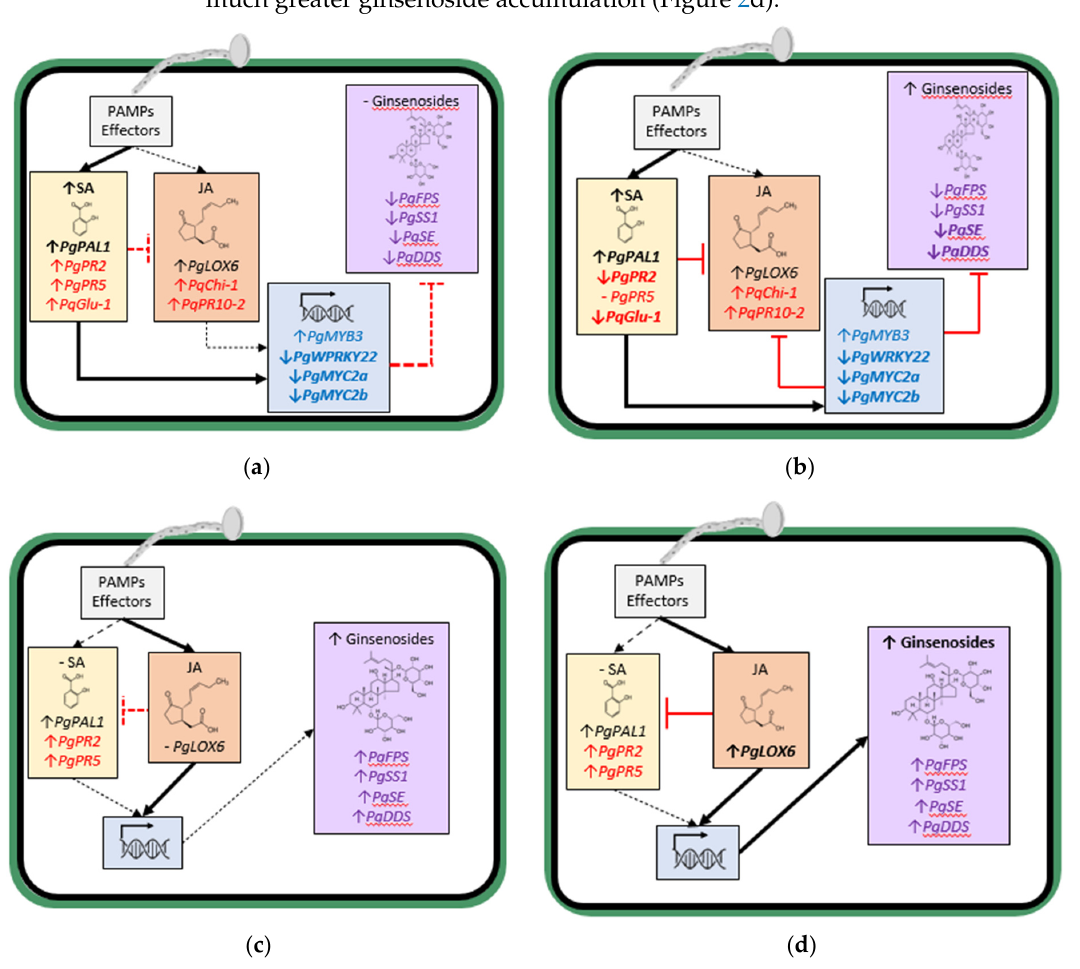
Figure 2. Aspects of SA and JA-associated host responses in ginseng roots with ( a ) the more aggressive I. mors-panacis at the early stage (0.5–8 dpi); ( b ) and late stage of infection (9–30 dpi); ( c ), and the less aggressive Ilyonectria spp. at the early stage (0.5–8 dpi); ( d ) and late stage of infection (9–30 dpi). Black lines between boxes indicate induction and red lines between boxes indicate suppression with dashed lines indicating a weak response and solid lines indicating a strong response. SA and JA synthesis gene designations are in black, PR protein gene designations are in red, TF gene designations are in blue, and ginsenoside synthesis gene designations are in purple. Arrows adjacent to gene designations indicate up or down gene regulation with bold indicating a stronger response. Illustration created with BioRender [18]. 4. Pathogenesis-Related Proteins PAMPs or effectors of plant pathogens typically trigger the production of host pathogenesis-related proteins (PR proteins) [49], which includes antioomycete and antifungal compounds, such as thaumatin-like proteins, chitinase and glucanase fungal cell wall degradation enzymes, proteinase inhibitors, and ribonucleases [50]. Among the DEGs identified in P. ginseng roots infected by C. destructans [29] , there were 29 DEGs for defence response, which included genes for the PR proteins, c55244_g1 described as part of the Bev v 1 family, and c58299_g4 without a description. Expression of c55244_g1 decreased from 0 to 0.5 dpi, increased at 4 dpi and decreased again at 7 dpi. Expression of c58299_g4 increased from 0 to 0.25 dpi, decreased at 0.5 dpi, increased at 4 dpi and decreased again at 7 dpi. The authors concluded that 0.5 dpi was the critical time point for resistance given the peak in up-regulation of total DEGs and RGs, and thus the increase in expression of c58299_g4 at 0.25 dpi could be part of the defence response. However, the fluctuating pattern of expression over time perhaps indicates periods of induction and suppression by PAMPs and effectors, respectively, or a relationship to other factors. Polygalacturonase inhibiting proteins (PGIPs) are plant cell wall glycoproteins that are considered PR-like proteins, with leucine-rich repeats that bind and inhibit pathogen secreted pectinases and act in defence signalling [51]. Infection by C. destructans increased PgPGIP expression by 1-fold at 6 h post-infection (hpi) and 10.5-fold at 1 dpi, followed by a decrease to basal levels at 2 dpi and 3 dpi [32]. It is possible that PgPGIP was part of PTI triggered early in the infection and then later suppressed by effectors from C. destructans . The authors only referred to the pathogen as C. destructans , and so it is not possible to know whether a more or less aggressive Ilyonectria species was used. The expression of two SA-responsive PR proteins, PgPR2 encoding an acidic β -1,3- glucanase and PgPR5 encoding a neutral thaumatin-like protein was compared between the infection by more or less aggressive Ilyonectria spp. in P. ginseng roots [28]. At 4 dpi with the more aggressive I. mors-panacis , PgPR2 expression was 1-fold higher and PgPR5 expression was 0.2-fold higher than the control, but by 16 dpi, PgPR2 expression was 0.2- fold and PgPR5 expression was 0.8-fold lower than the control. With the less aggressive I.